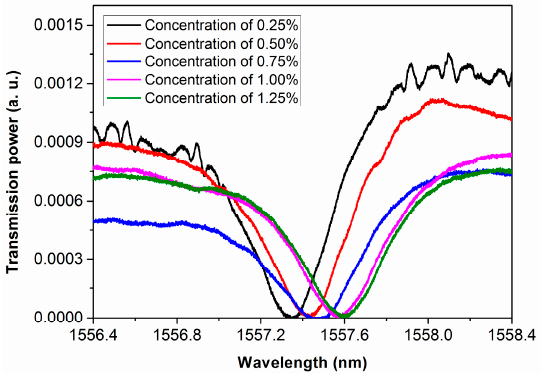
Figure 13. The close-up view of the spectral dips around 1557 nm wavelength measured at different doping concentrations of salt.